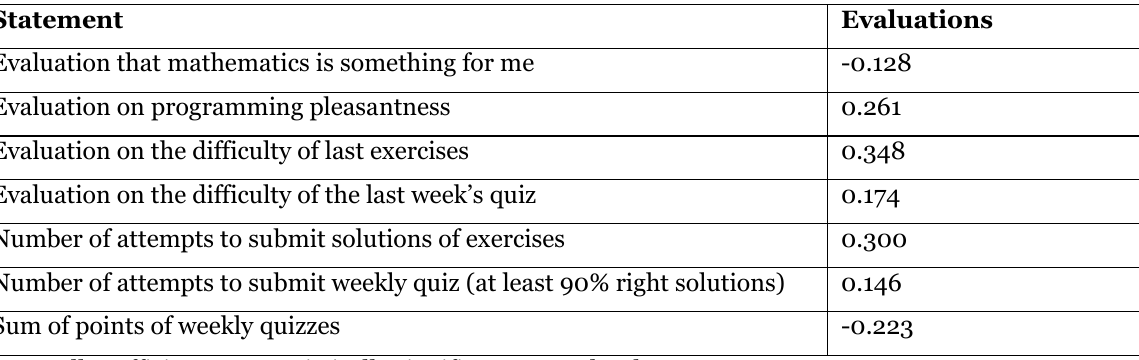
Spearman Correlation Coefficients Between Participants Evaluations on Various Statements and Their Evaluations on the Usage of